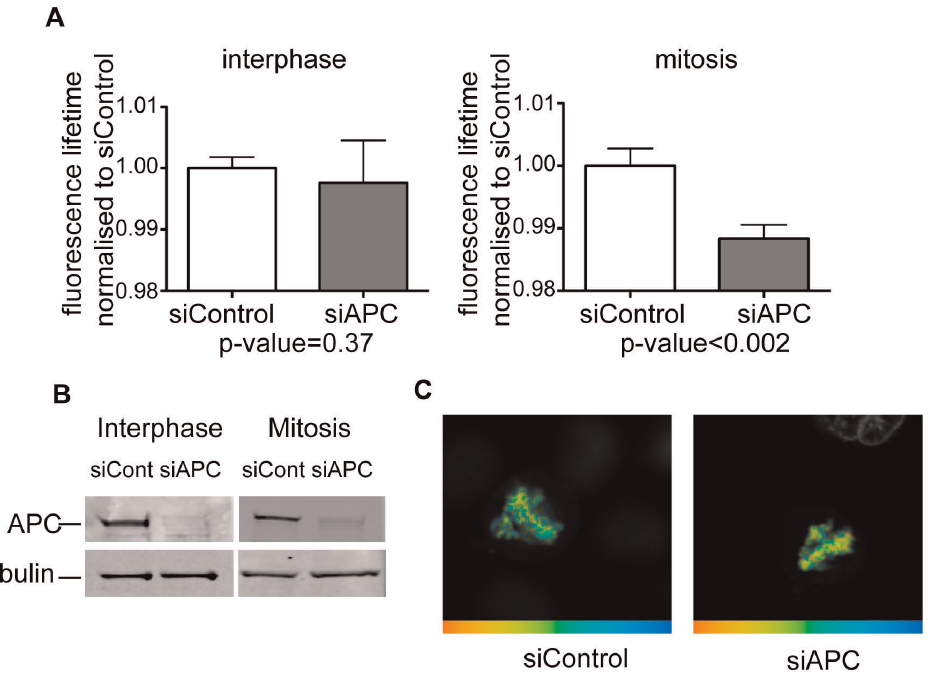
Figure 2. APC depletion increases chromatin compaction in HeLa cells. Asynchronously growing HeLa cells stably expressing GFP-H2B and mCherry-H2B were depleted of APC using siRNA (siAPC) or transfected with non-targeting siRNA (siContr), and donor fluorescence lifetime was measured using time-correlated single photon counting technique. A . Normalised lifetime values for APC- (grey bars) and mock- (white bars) depleted interphase cells (left) and mitotic cells (right). P-values are given underneath the plots. Please note that APC-depleted mitotic cells display significantly shorter FRET lifetime, indicating a higher degree of chromatin compaction. At least ten cells were measured for each condition. B . Level of APC depletion of cells used in A is visualized by immunobloting the corresponding lysates with anti-APC antibodies. Tubulin is used as a loading control. C . Representative chromatin images from control (left) and APC-depleted (right) mitotic cells. FRET efficiency is shown in false colors, with blue corresponding to low FRET efficiency (i.e. less compaction), and red corresponding to high FRET efficiency (i.e. more compaction).